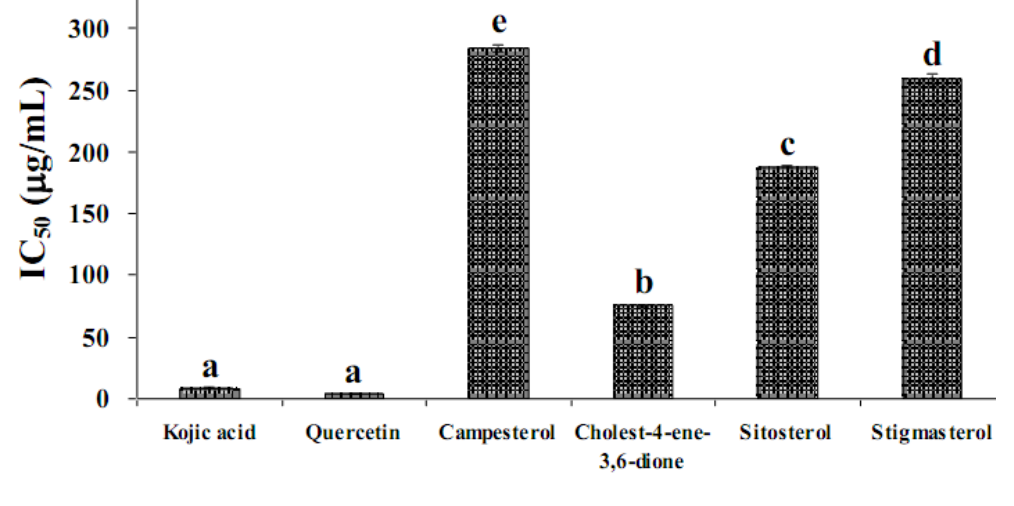
Figure 1. Inhibitory effect of steroidal compounds on ( A ) tryrosinase; ( B ) pancreatic lipase; ( C ) 15-lipoxygenase; and ( D ) LDL oxidation activities. Mean with the same letter on the bars are not significantly different, p = 0.01 (Tukey HSD). The bars represents mean ± SD ( n =